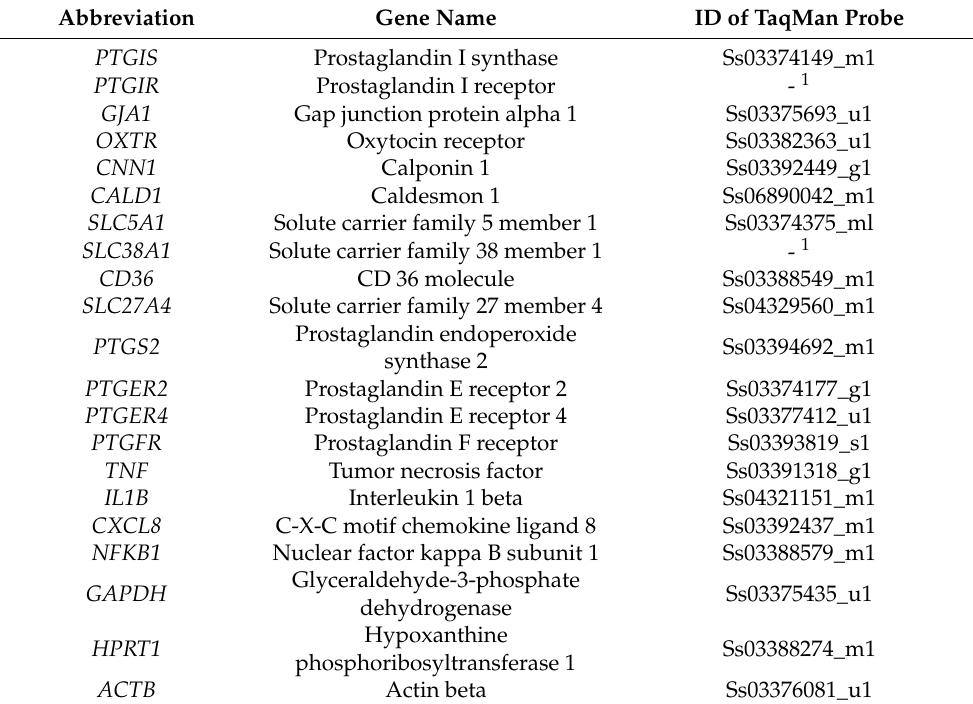
Table 1. Full names of genes exploited to examine the mRNA transcript abundance with real-time